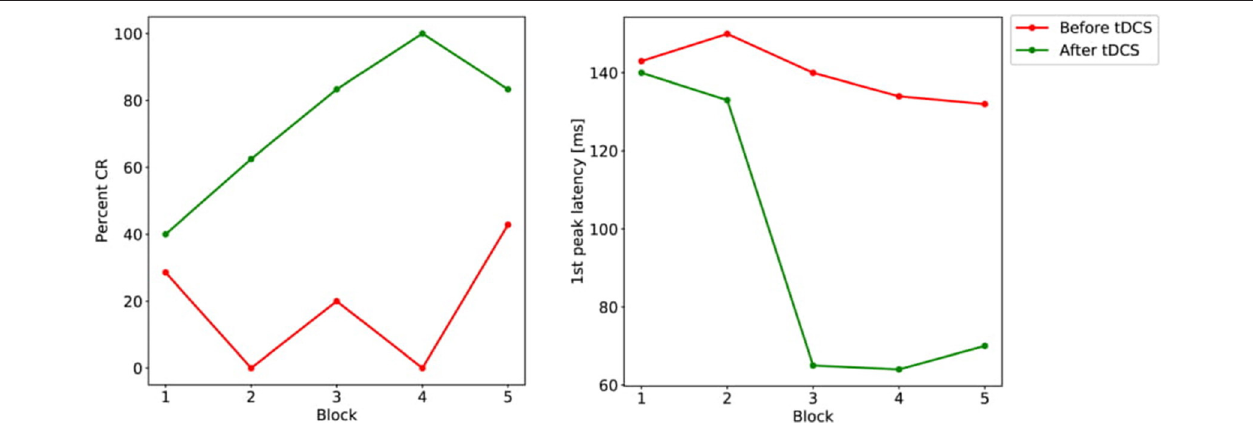
FIGURE 3 | Percentage of CRs and latency of the first peak progression from block to block before (red) and after (green) tDCS. Left panel: percentage of CRs from each block measured in the red rectangle indicated on Figures 2C,D . Right panel: First peak latency calculated from the data averaged in blocks in Figures 2A,C . Time zero for latency calculation corresponds to the onset of the